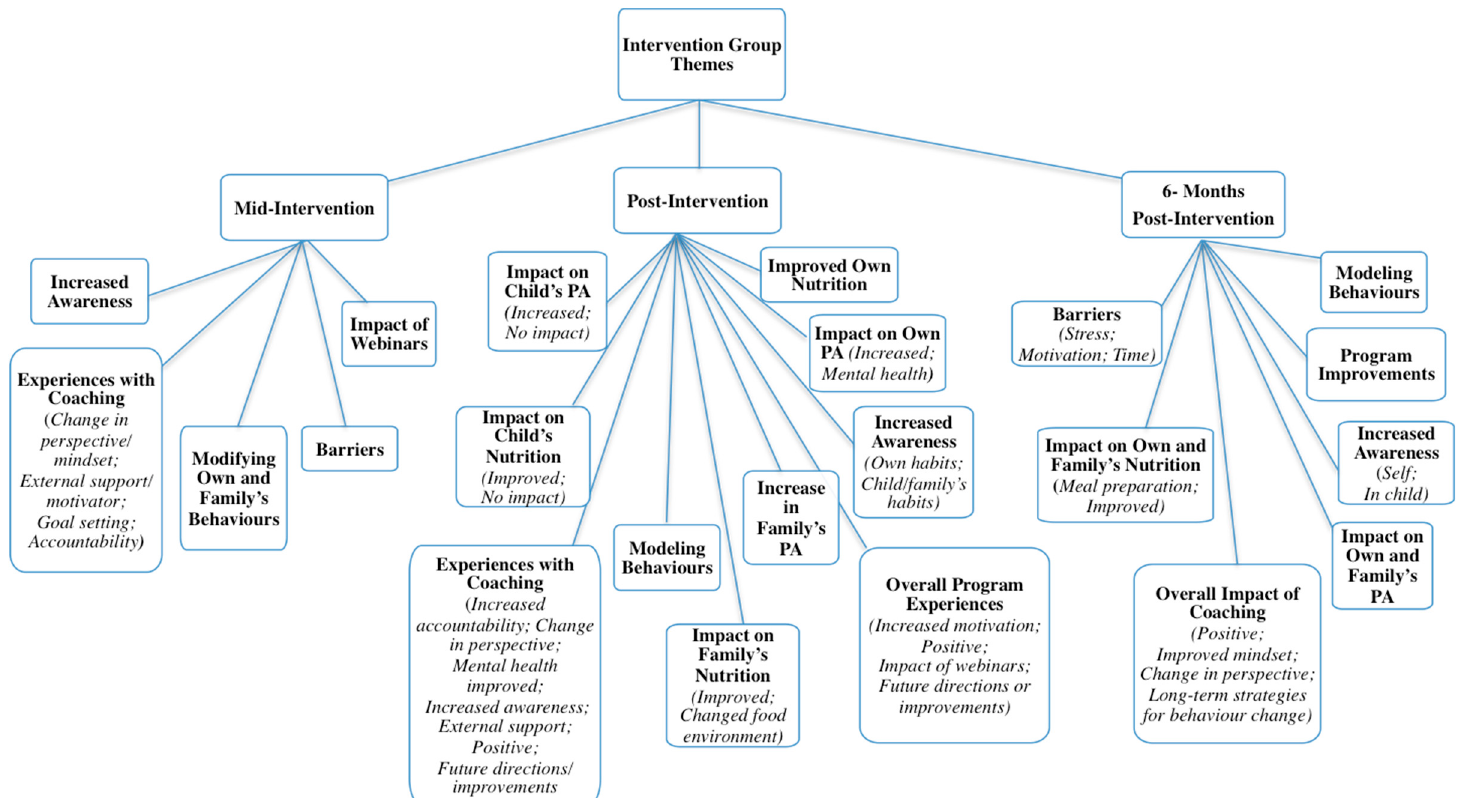
Figure 3. Intervention themes from all relevant time points.